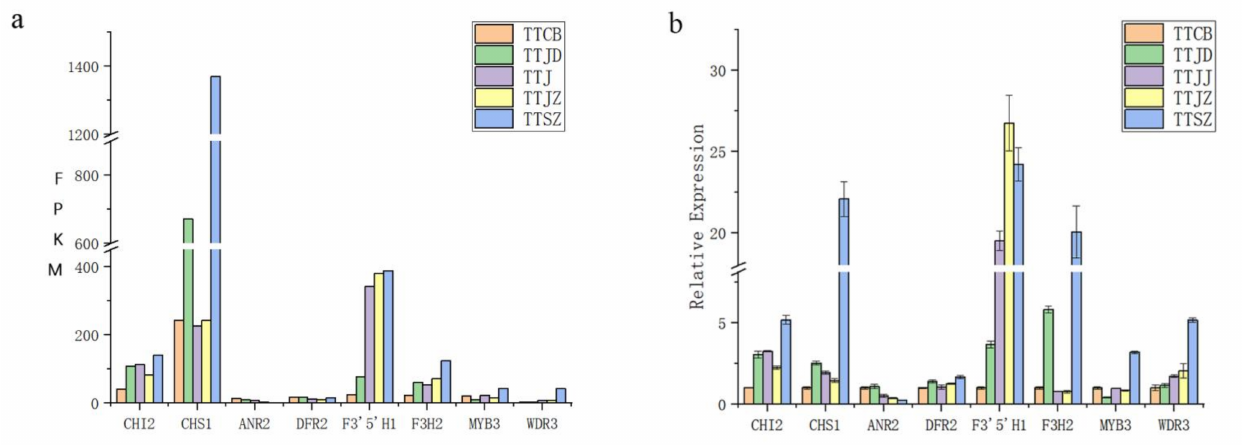
Figure 6. qRT-PCR identification of selected genes related to anthocyanin biosynthesis. ( a ) Expression levels of 8 unigenes based on the FPKM level. ( b ) Relative expression levels of 8 unigenes determined using qRT-PCR. The error bars represent the standard deviations from three